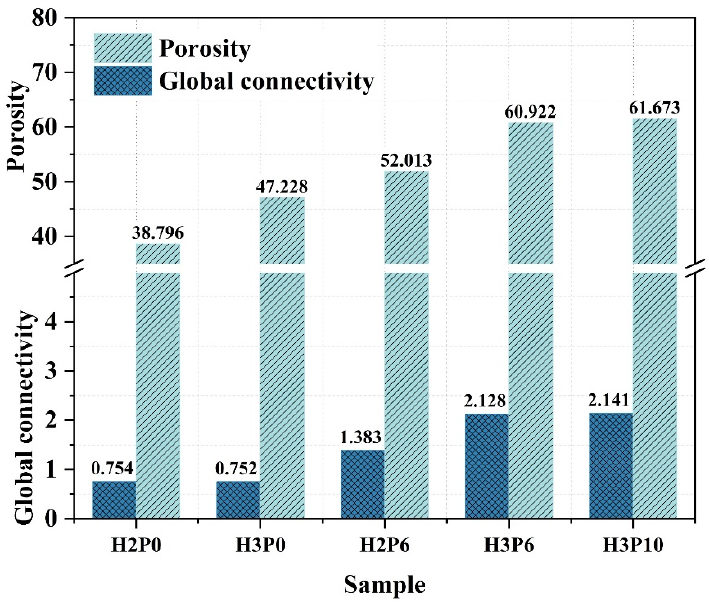
Figure 16. Global connectivity and macropore porosity of geopolymer foams.